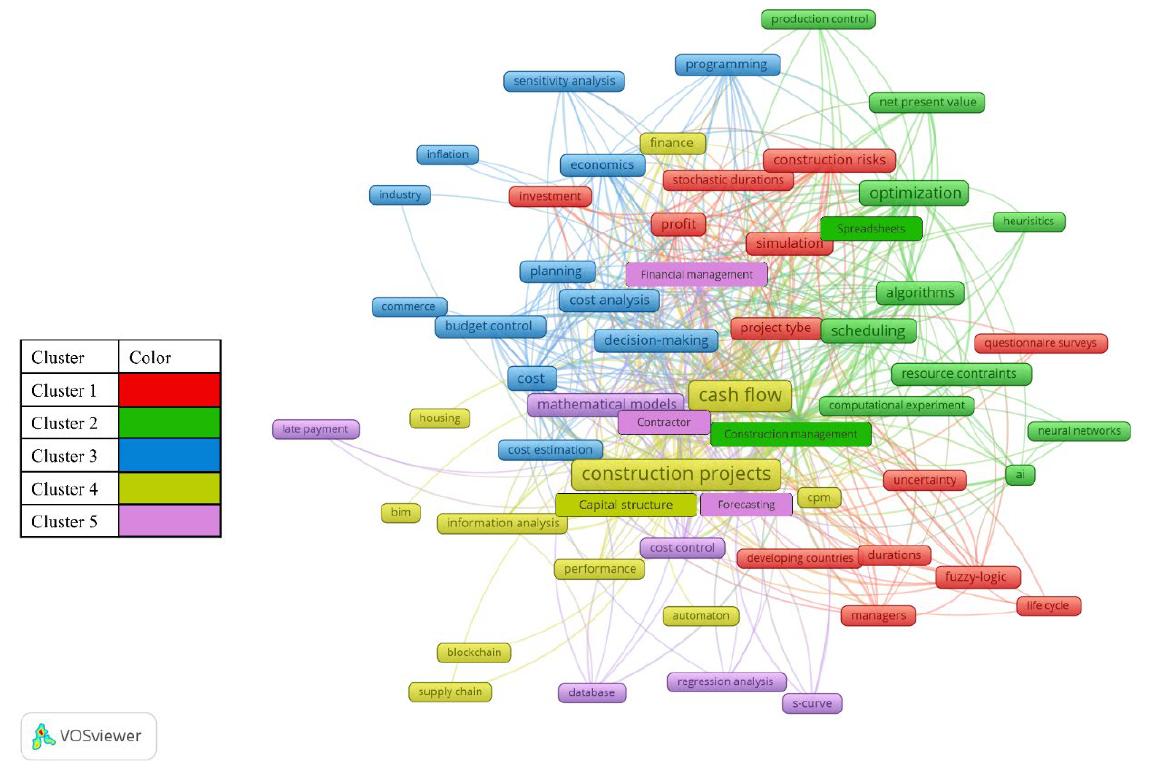
Figure 6. Clustering structure for research on cash flow analysis in the construction industry.